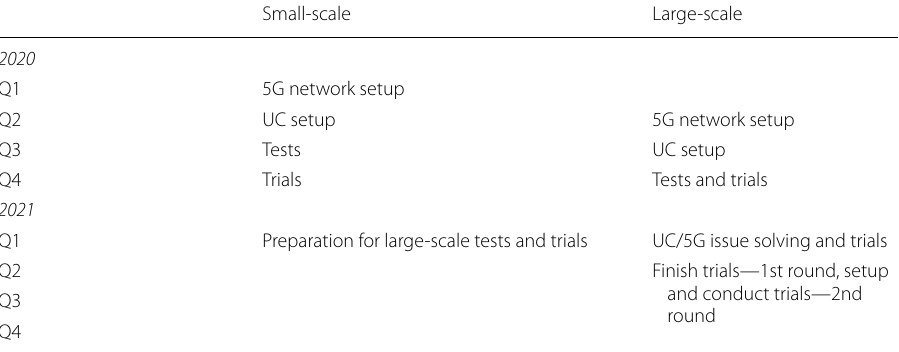
Table 1 5GCroCo tests and trials